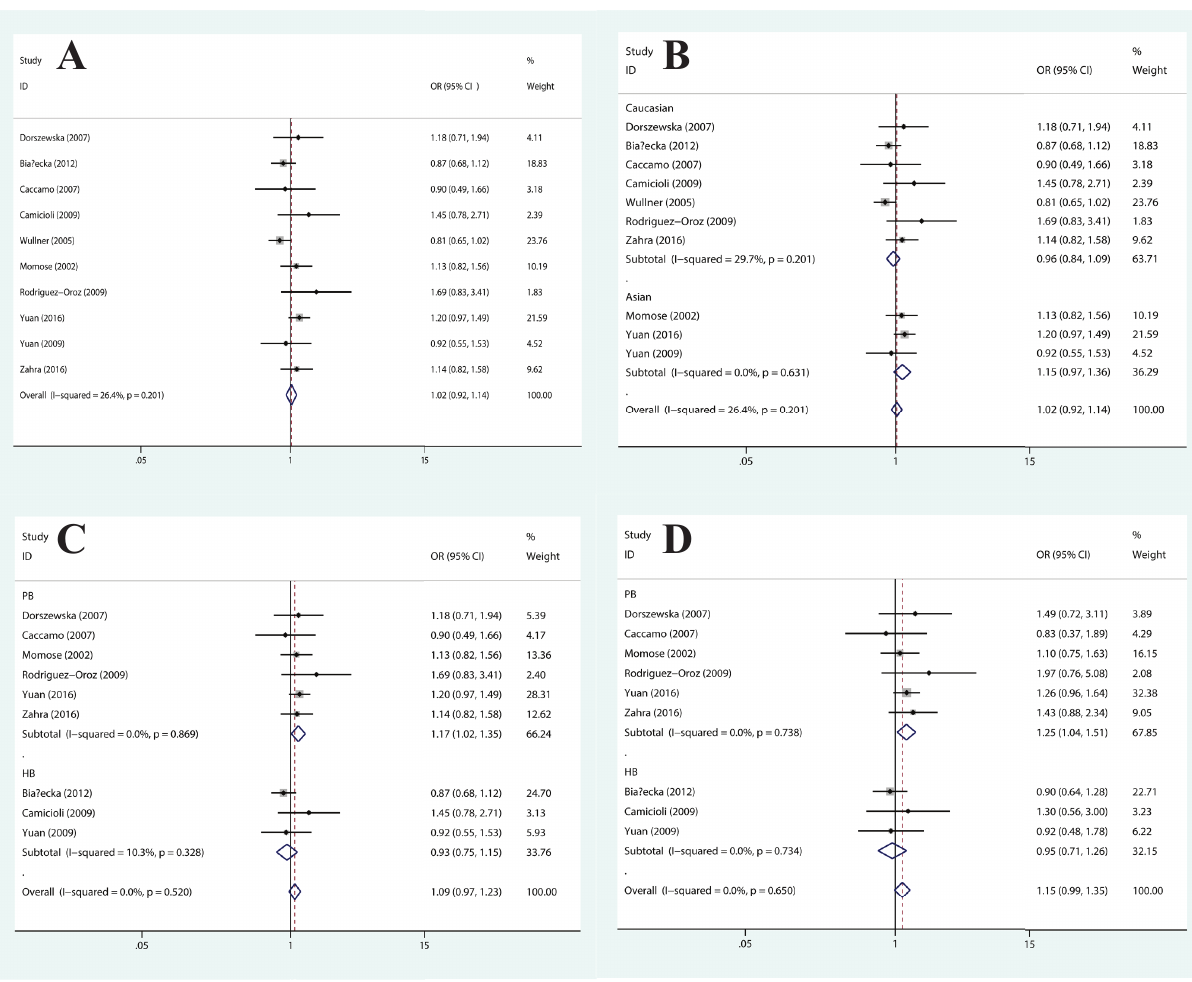
Figure 3: Forest plot of the association between MTHFR A1298C polymorphism and PD susceptibility: (A) allelic genetic model in the overall populations; (B) allelic genetic model, stratified by ethnicity; (C) allelic and (D) co-dominant genetic model, stratified by source of